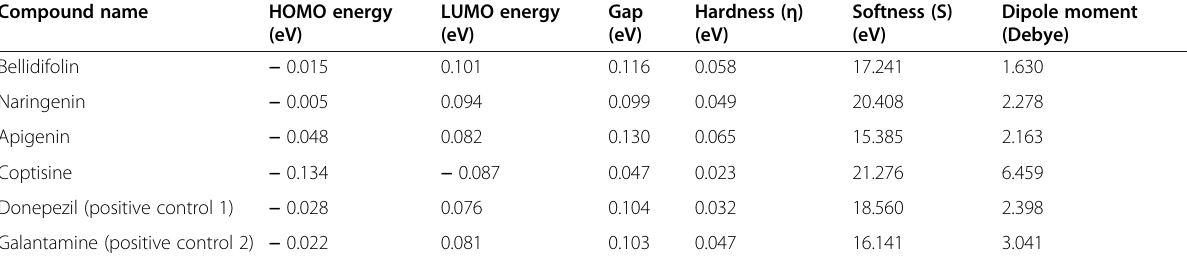
Table 9 The results of the DFT calculations of the selected best 4 ligands and the positive controls